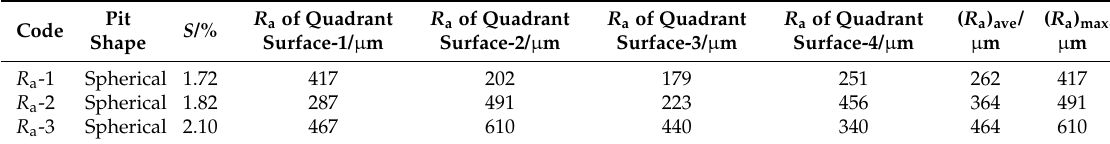
Table 8. Constructor parameters of corroded reinforcement.